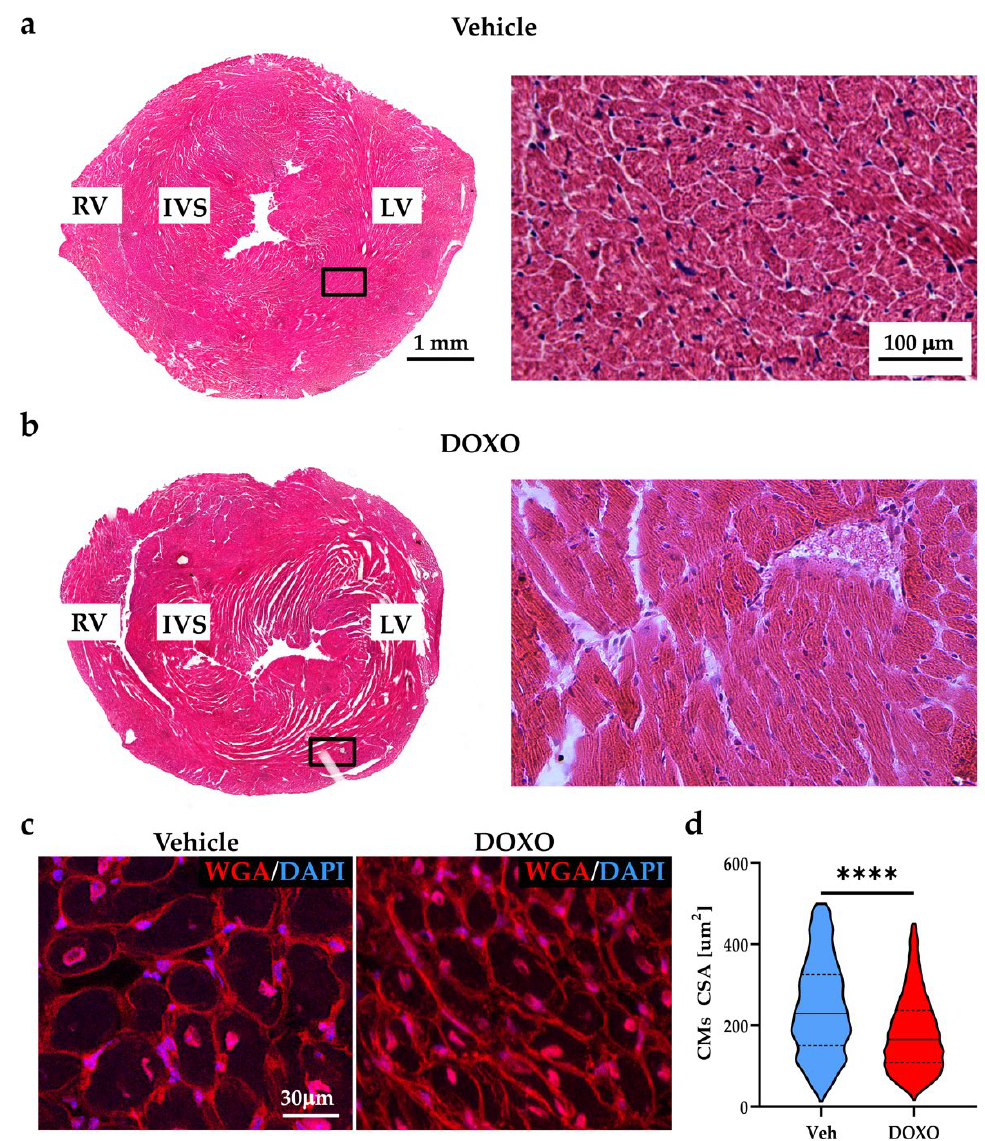
Figure 2. DOXO treatment leads to cardiac atrophic remodeling. ( a , b ) Hematoxylin-eosin staining in heart sections from the vehicle- ( a ) and DOXO- ( b ) treated mice, six weeks after the completion of DOXO administration. Right panels in ( a , b ) are high magnification of the black boxed areas in the left panels. ( c ) Confocal immunofluorescence on heart sections from the mid-portion of the ventricles of vehicle- vs. DOXO-treated mice, stained with Alexa Fluor™-555-conjugated wheat germ agglutinin (WGA). The nuclei were counterstained with 4',6-Diamidino-2-Phenylindole (DAPI). Images were used to calculate the cardiomyocyte (CM) cross-sectional areas (CSA) ( d ). Differences among the groups were determined using a Mann–Whitney test. (n > 2500 CMs from four different hearts for each group; ****, p < 0.0001). The solid line on violin plot represents the median, dashed lines are 25/75 percentiles. RV, right ventricle; IVS, interventricular septum; LV, left ventricle; DOXO, doxorubicin; Veh, vehicle.